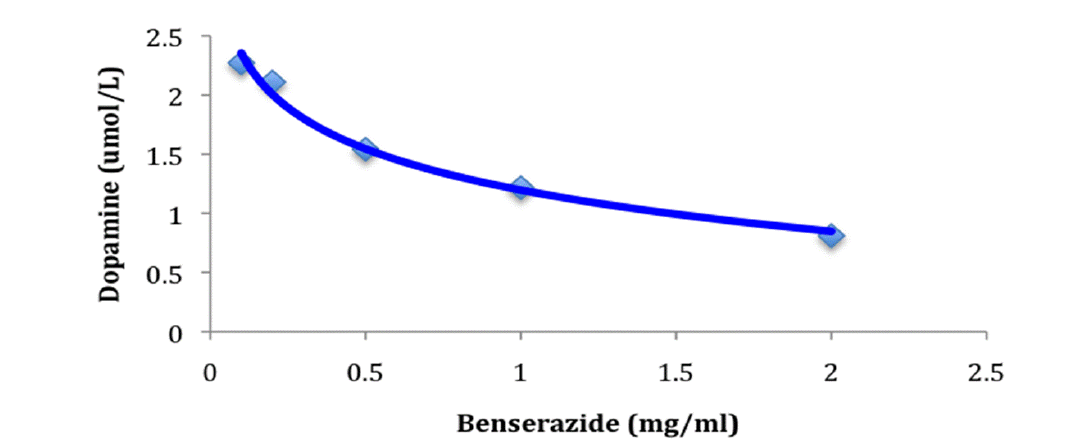
Figure 6: Benserazide inhibition of dopamine: benserazide at increasing concentrations reduce L -DOPA dopamine synthesis in SH-SY5Y. 3.5